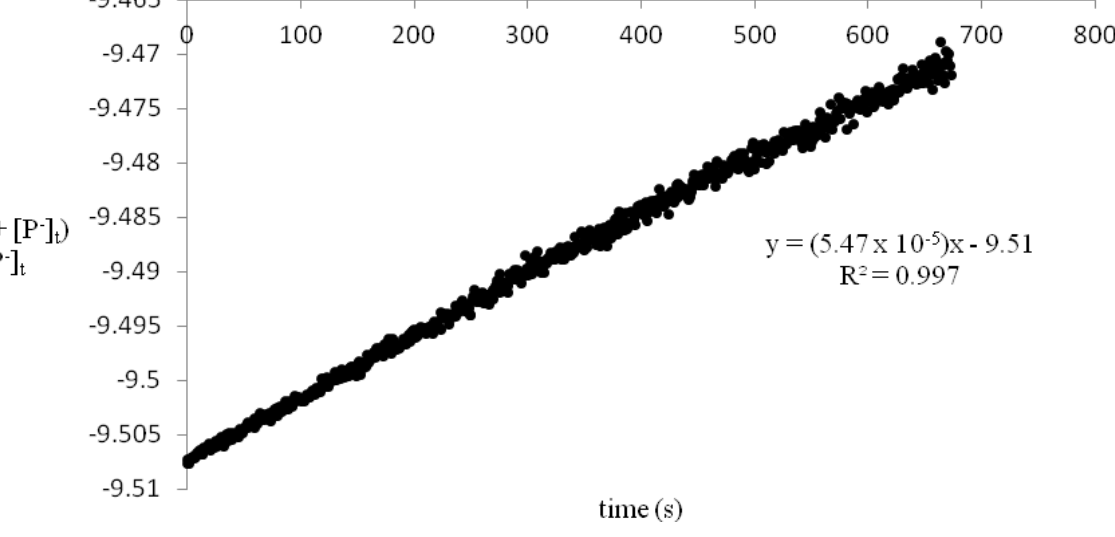
+ [P − ] ) − ln[P − ] vs. time for reaction of 3.12 × 10 − 5 M benzylamine o t t